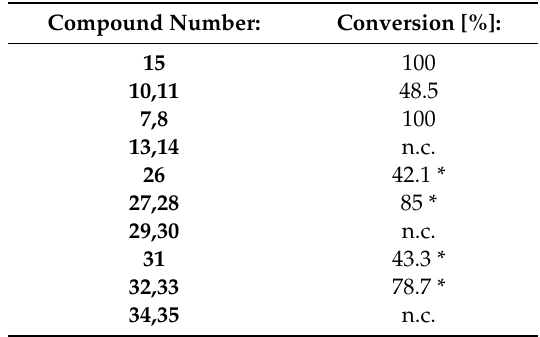
Table 1. Summary of PHA modifications and their sugar esters